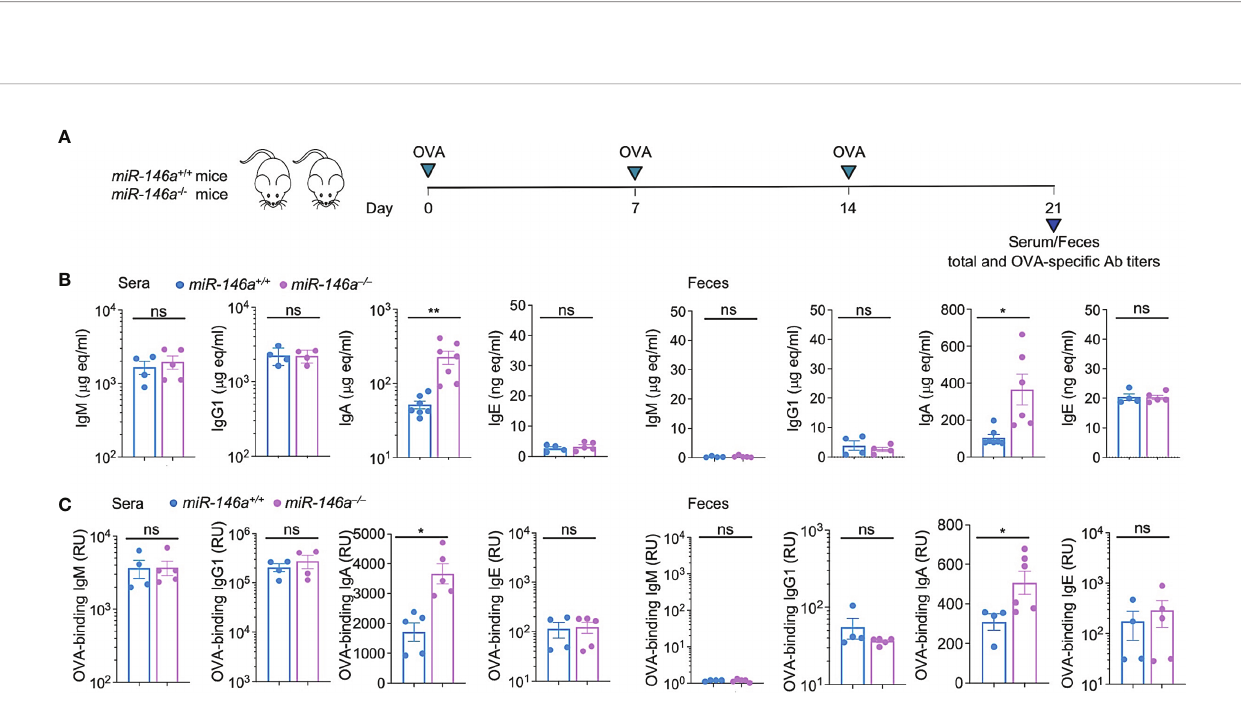
FIGURE 2 | Increased IgA production in miR-146a – / – mice. (A) miR-146a – / – and miR-146a +/+ mice were administered OVA together with CT via intragastric gavage once a week for 3 wks and sacri fi ced one wk after the last OVA administration for analysis of antibodies, B cells and ASCs. Total (B) and OVA-binding (C) IgM, IgG1, IgA and IgE titers, as measured by ELISA in serum and feces. ** p < 0.01, * p < 0.05, ns, not signi fi cant, unpaired t -test. Data are mean ± SEM of 4-7 miR- 146a – / – or miR-146a +/+ mice from three independent